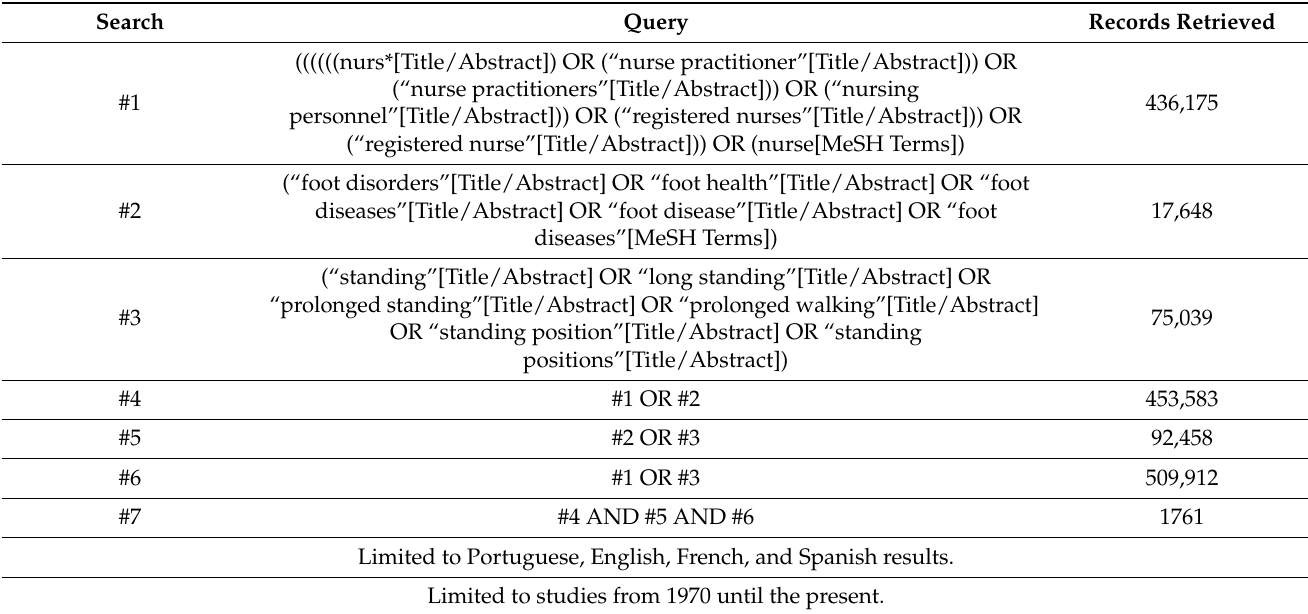
Table 1. Search strategy for MEDLINE (PubMed) conducted on 29 December 2020. Search Query Records